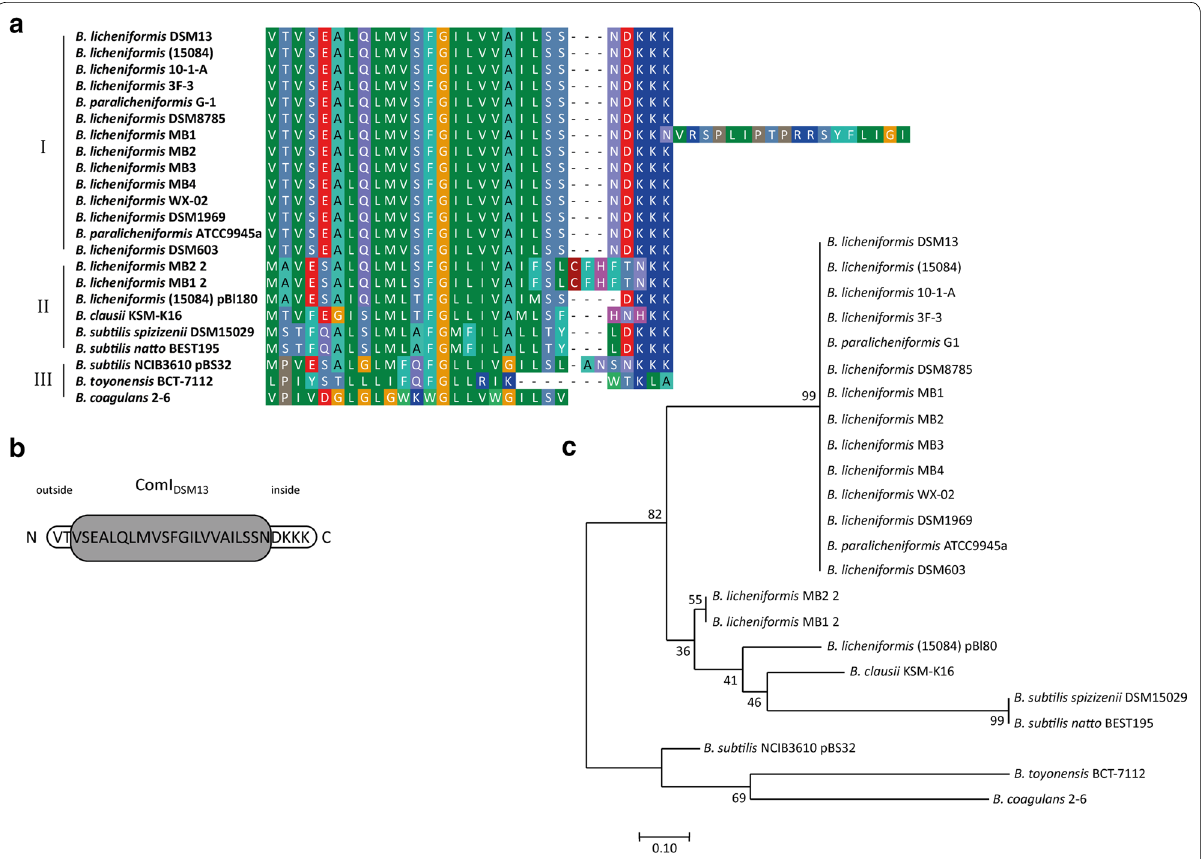
Fig. 1 Alignment of ComI homologs predicted for different Bacillus species. a ComI homologs were identified in 20 strains. Dark blue boxes refer to basic aa, red boxes to acidic aa. Hydrophobic aa are displayed as green-shaded boxes whilst polar, uncharged aa are bluish violet-shaded . Glycine is given in yellow , cysteine in maroon and histidine in pink . b Primary structure of ComI DSM13 . Amino acids are given in single‑letter code. The N and C termini are indicated as well as the position inside and outside of the cell. The grey-shaded protein area indicates the predicted transmembrane helix. c Similarity of 23 ComI protein sequences from 20 different Bacillus strains. The reliability of the tree was calculated using the bootstrap test (500 replicates) and is shown next to the branches (Felsenstein 1985). The tree shows three ComI